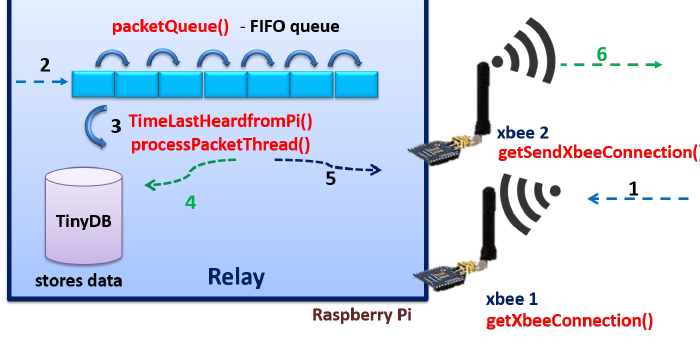
Figure 8. The relay